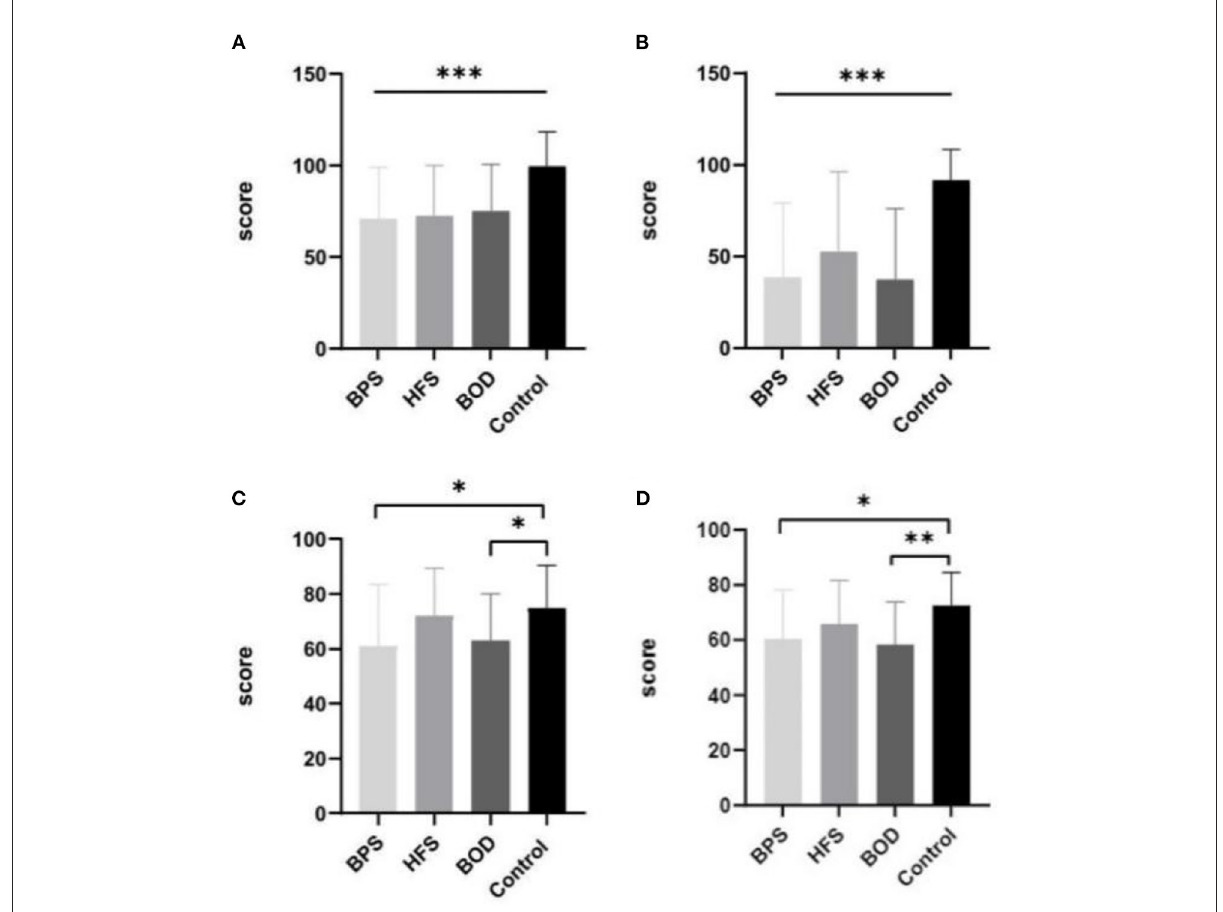
FIGURE1 The comparison of mean SF-36 scores between groups. Compare to the control group, the mean scores in BPS, HFS, and BOD for SF (A) and RP (B) were significantly lower ( P < 0.001). The VT score (C) was lower in the BPS group and BOD groups than in the control group ( P < 0.05). The MH score (D) in the BPS ( P < 0.05) and BOD ( P < 0.01) groups significantly differed from the control